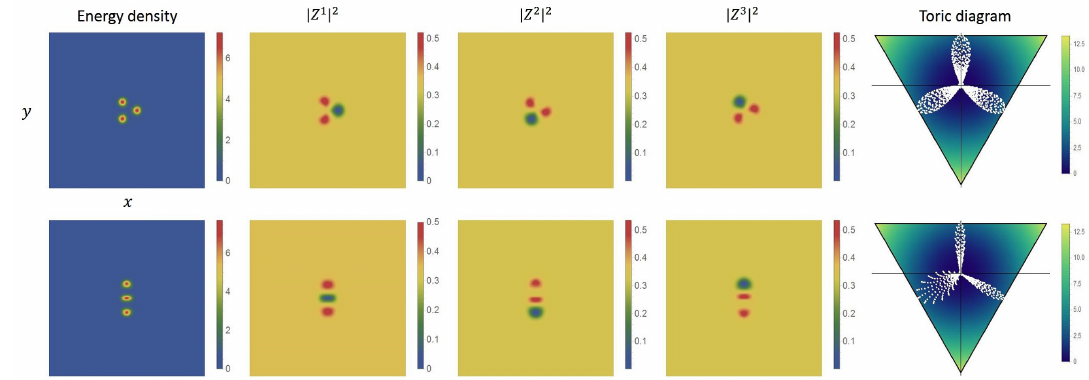
Figure 2 . The energy density, the norm of the homogeneous coordinates, and the toric diagram of the Q = 1 solutions with the coupling constants ( M 2 , κ 2 , µ 2 ) = (1 , 16 , 10) . The dots in the toric diagram represent the values ( n 3 , n 8 ) on each lattice point of the numerical solution, and the color of the background shows the value of the potential.